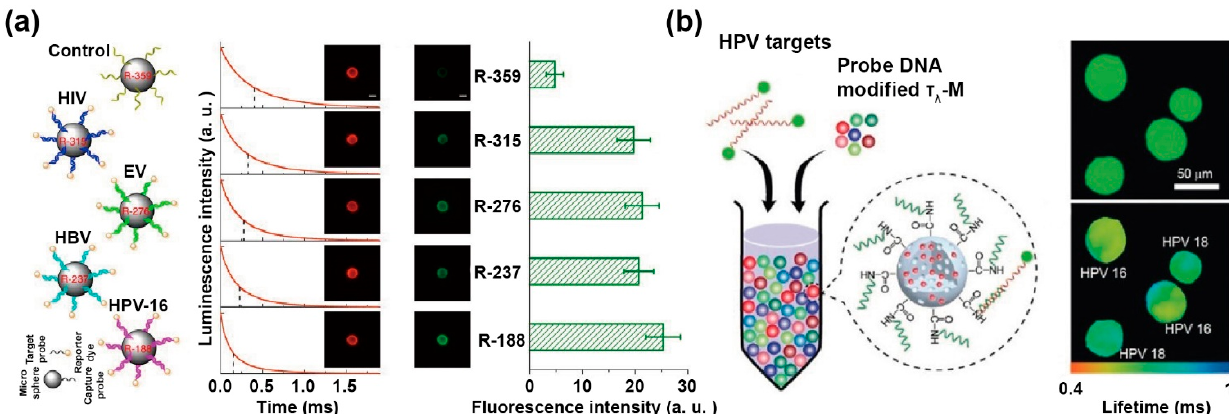
Figure 8. ( a ) Diagram of the five types of Eu-LRET microspheres conjugated to five different DNA sequences, in which the microspheres and amounts of pathogen DNAs were confirmed by the luminescence decay curves of Eu 3+ and reporter fluorescence intensities, respectively. Reproduced with permission from [75]. Copyright 2014, Nature Publishing Group. ( b ) Schematic diagram of τ λ -M for detecting HPV subtypes, and the confocal images with the corresponding lifetime images after incubating complementary target DNAs, respectively. Reproduced with permission from [42].